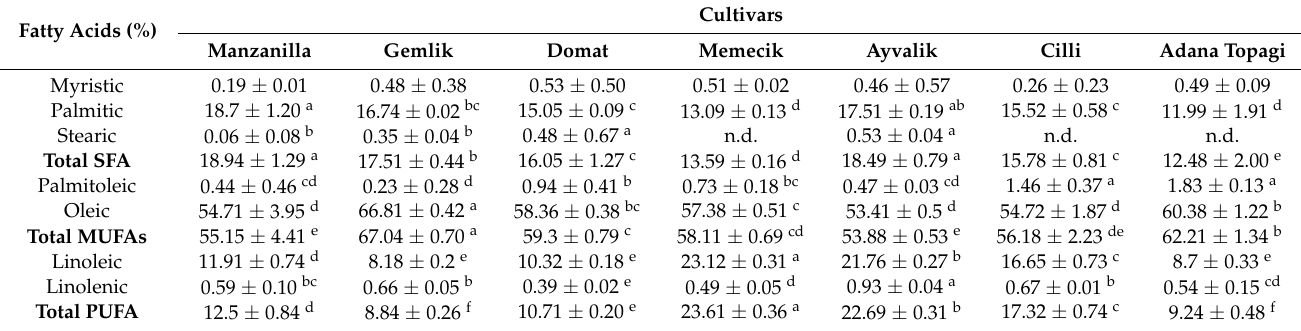
Table 4. Characterization of fatty acids by GC-FID ( n =